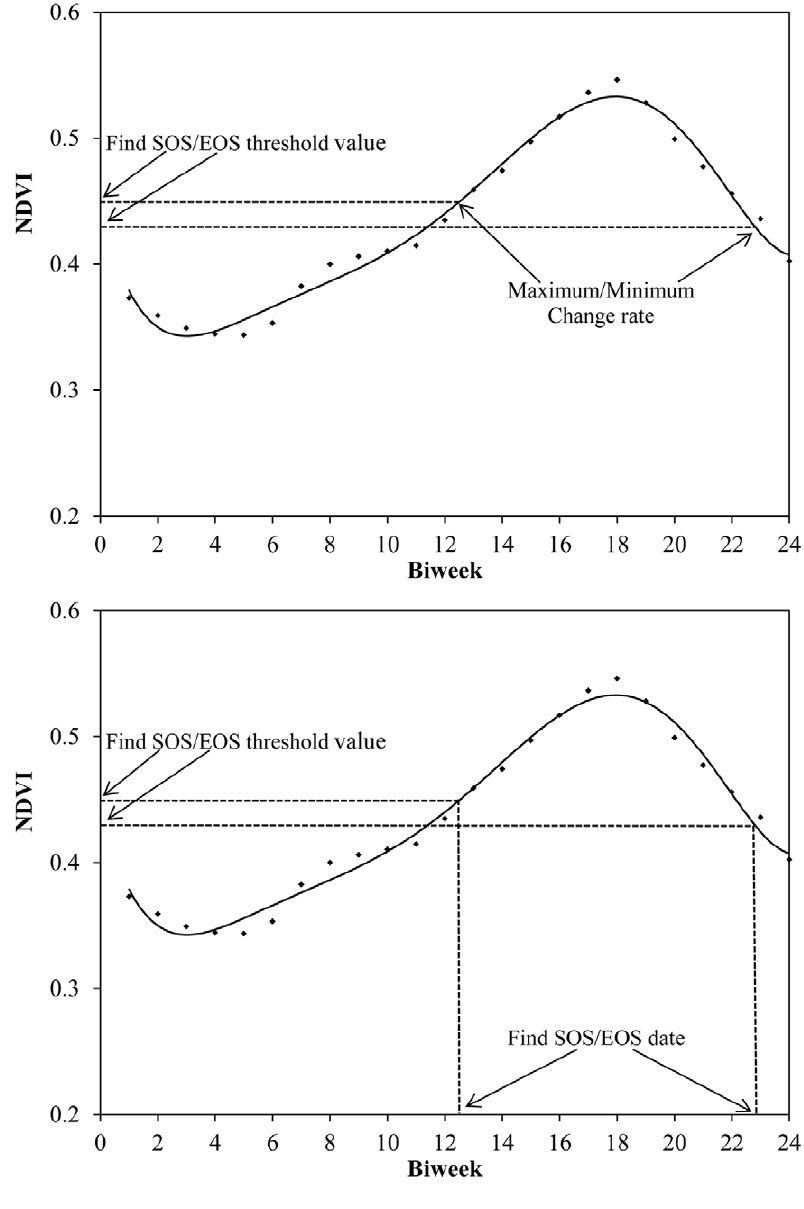
Figure 1. Climatology of a single pixel and schematic of retrieving of SOS and EOS (Modified from [ 29 ] ).